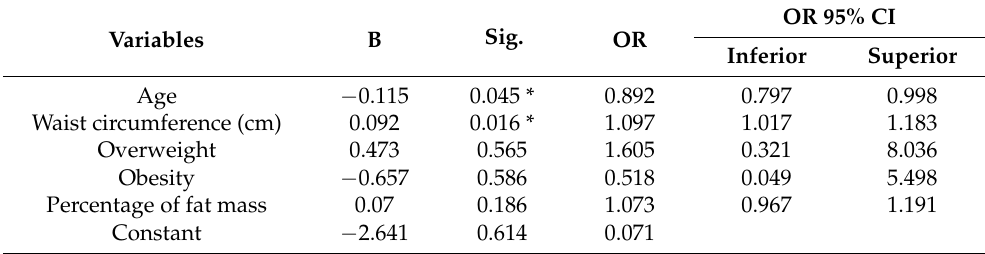
Table 3. Multivariate logistic regression which explained the presence of NAFLD. OR 95% CI Variables B Sig. OR Inferior Superior Age − 0.115 0.045 * 0.892 0.797 0.998 Waist circumference (cm) 0.092 0.016 * 1.097 1.017 1.183 Overweight 0.473 0.565 1.605 0.321 8.036 Obesity − 0.657 0.586 0.518 0.049 5.498 Percentage of fat mass 0.07 0.186 1.073 0.967 1.191 Constant − 2.641 0.614